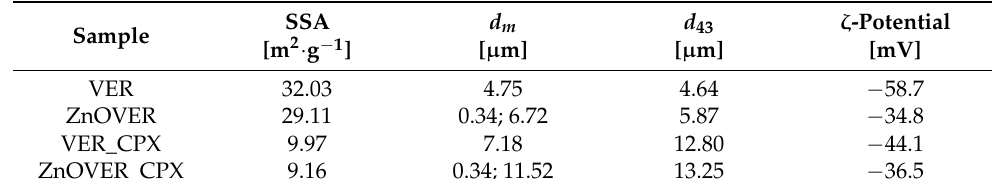
Table 1. The specific surface area (SSA), particle size parameters ( d m , d 43 ), and ζ -potential values of clay nanofillers.